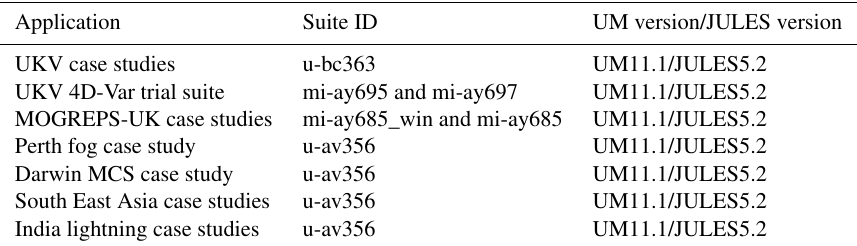
Figure 15. NCMRWF 16 April 2019 lightning case study: RAL1 (top) and RAL2 (middle). Panels (a) – (e) are total lightning flashes, panels (b) – (f) are total ice water path, panels (c) – (g) are total graupel water path, and panels (d) – (h) are vertical velocity at 500hPa. Panel (i) is accumulated lightning flash counts from IAF and IITM observations. Table 3. Identifiers for a set of RAL2 reference simulations across a number of systems and/or applications. These suites are held on the Met Office Science Repository Service, which also holds the UM and JULES